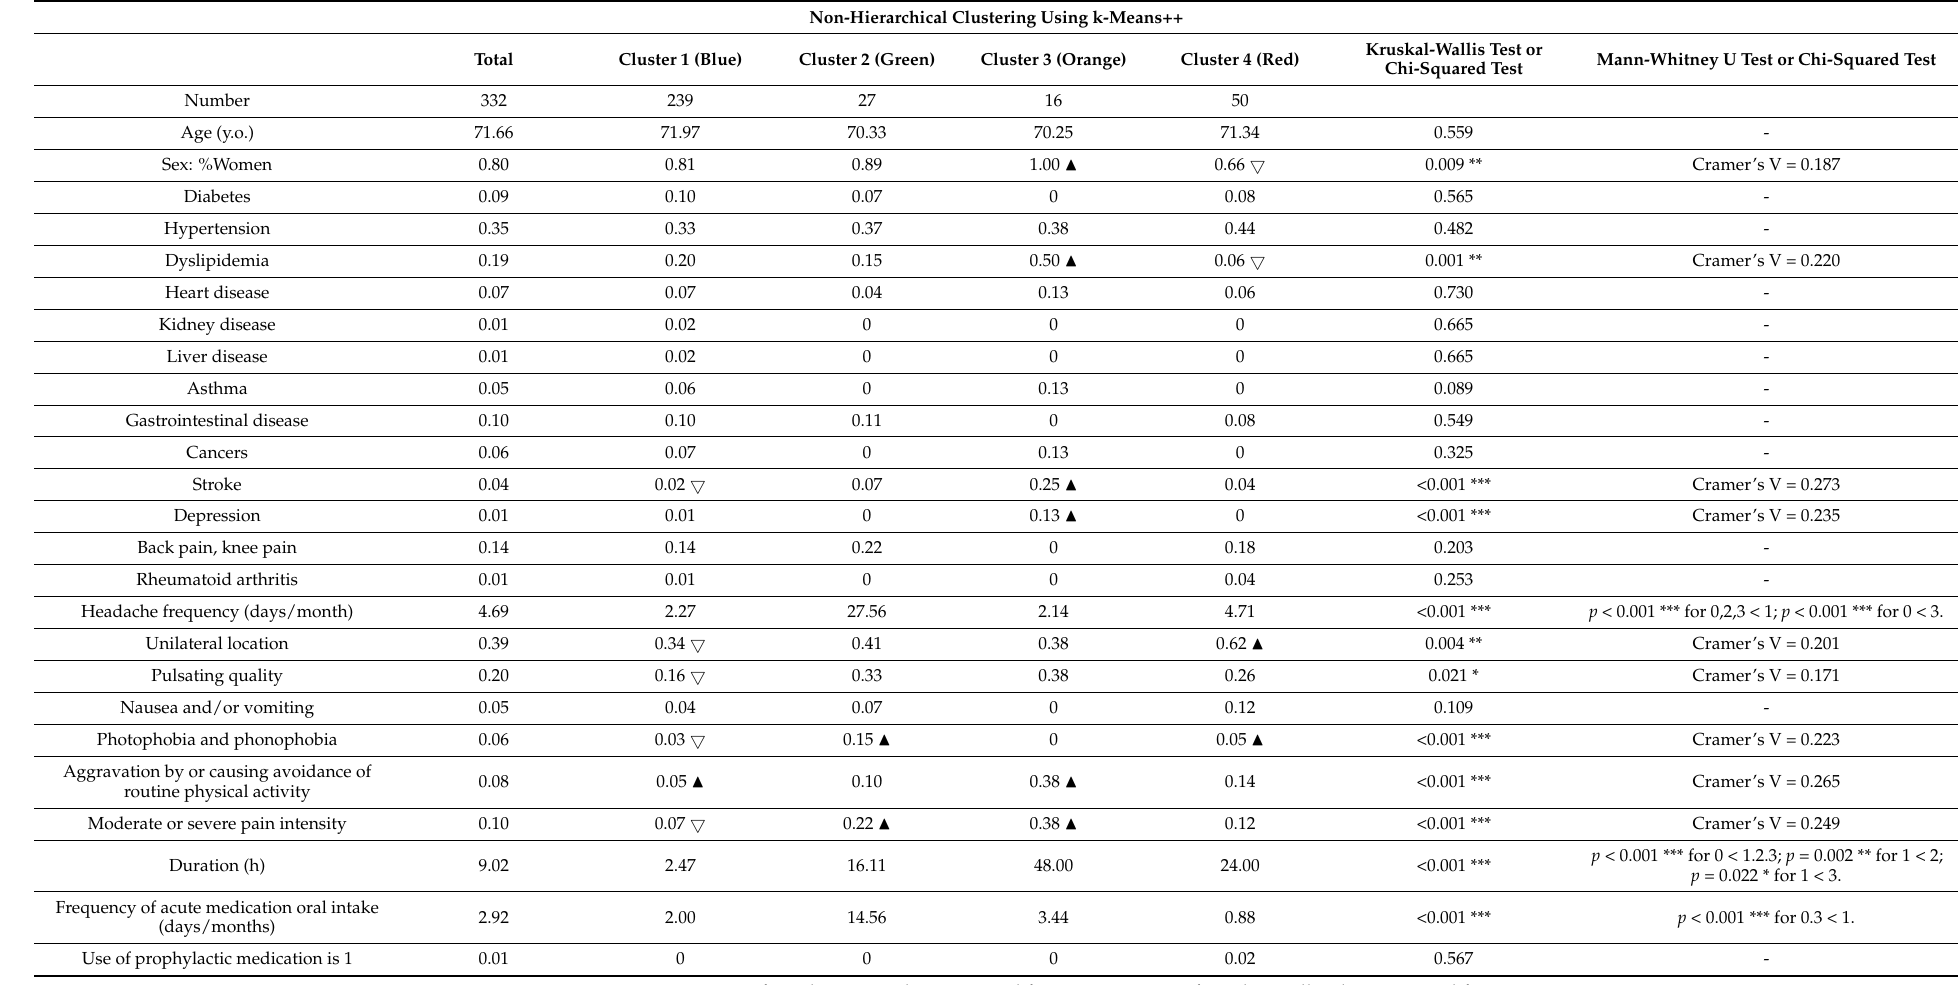
Table 4. Means of each variable among